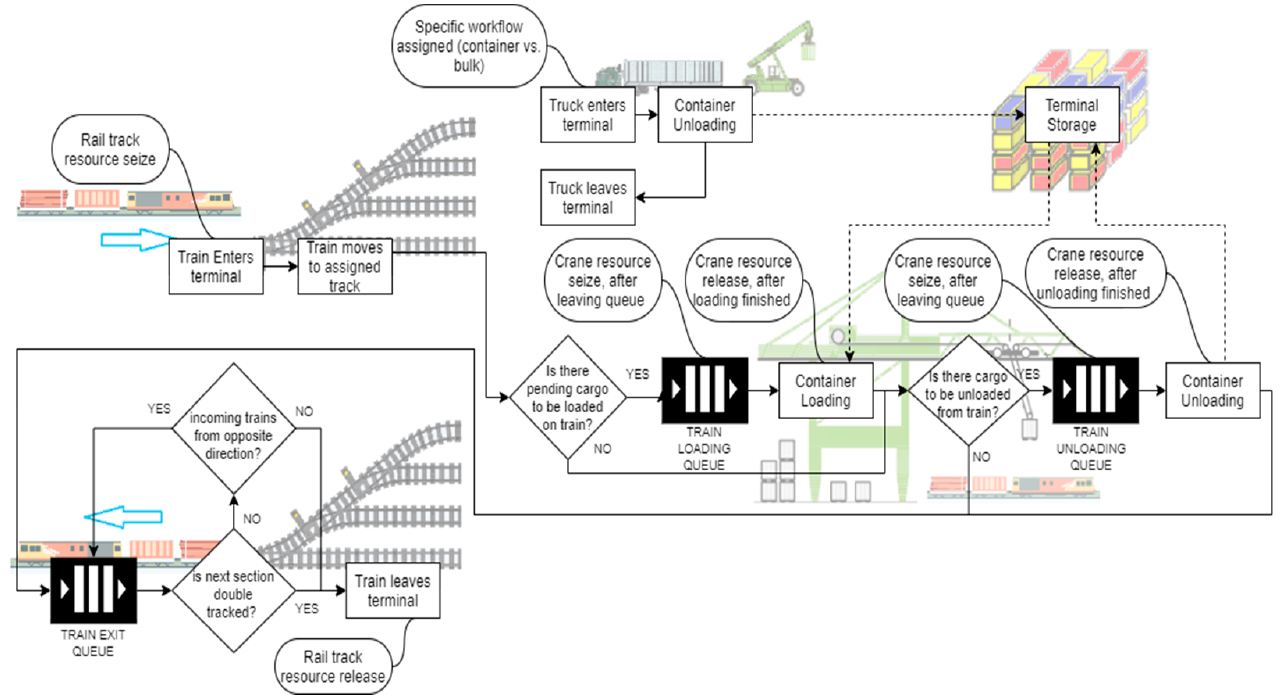
Figure 3. General workflow for terminal logic.